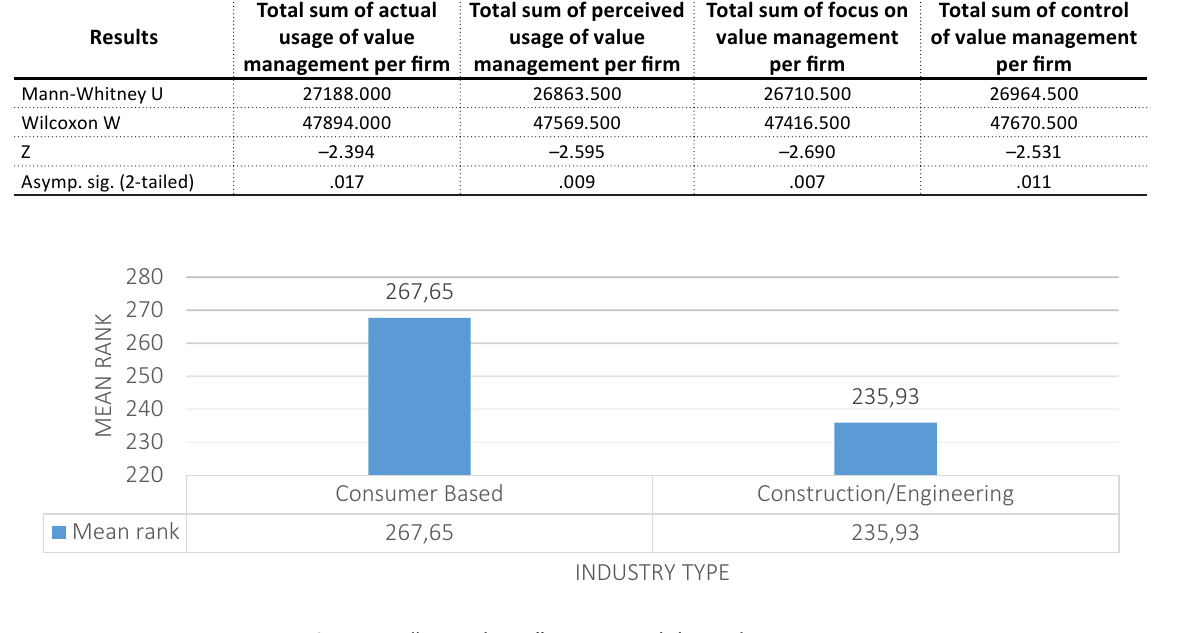
Figure 3. “Actual use” mean rank by industry type